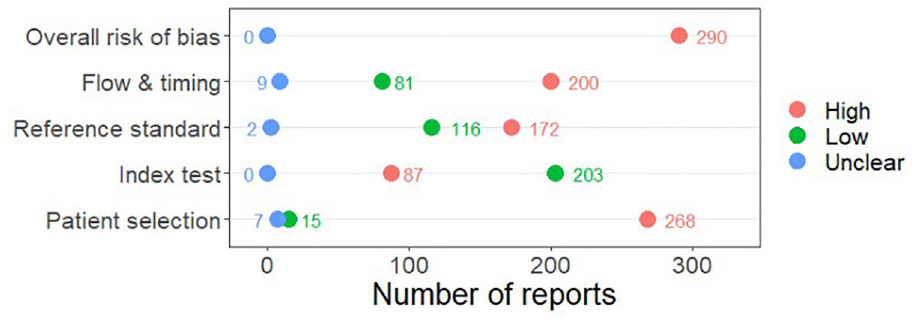
Fig 2. Summary graph of risk of